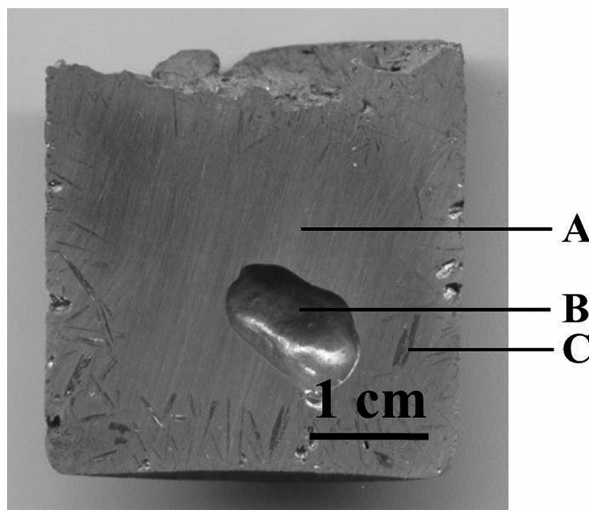
Figure 2: The cross section of solidified sample